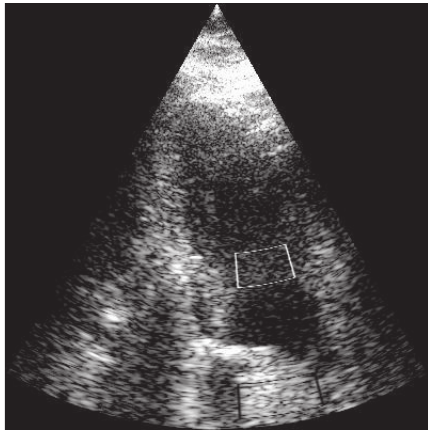
Figure 10: Example of ROI from an apical view of a volunteer heart view for measuring CNR. The upper white box corresponds to the